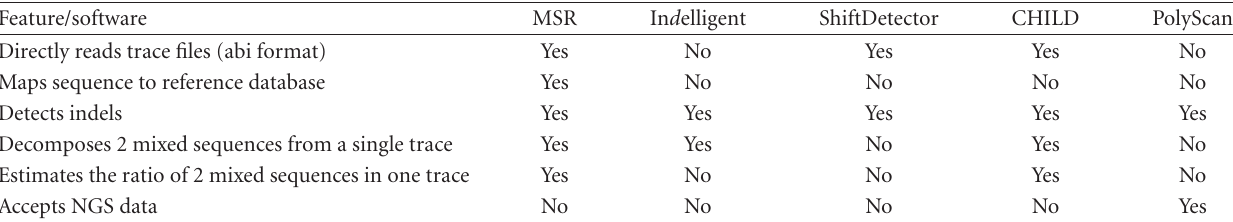
Table 1: Feature comparison between MSR and other currently available DNA sequencing software. Feature/software